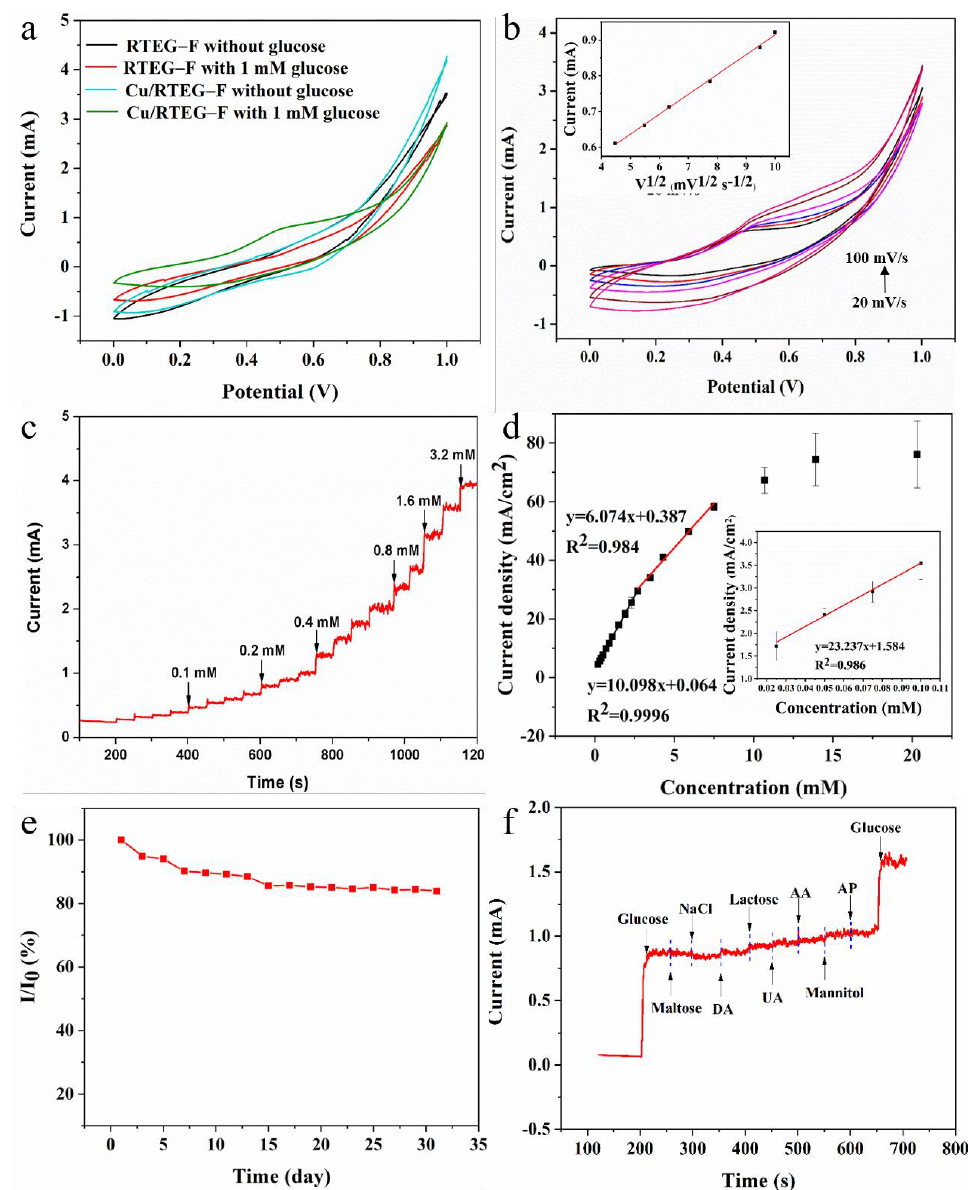
Figure 3. ( a ) CV curves of pristine RTEG-F and Cu/RTEG-F electrodes with or without the addition of 1.0 mM glucose at a scan rate of 50 mV s −1 . ( b ) CV curves of Cu/RTEG-F electrode at different scanning rates in NaOH solution containing 1.0 mM glucose. Inset: dependence of the glucose oxidation peak current on the scanning rate. ( c ) Amperometric current responses of Cu/RTEG-F electrode continuous adding of various concentration of glucose (e.g., adding four times of 1 µ L of 1.0 M glucose solution into NaOH solution will increase the concentration of glucose in the system to 0.025 mM every time). ( d ) The relationship between the glucose concentration (2.7 mM to 20.3 mM) and the corresponding current density. Inset: the relationship between the glucose concentration (0.025 mM to 2.7 mM) and the corresponding current density ( n = 3). ( e ) The relationship between the glucose concentration and the corresponding current density. ( f ) The current response of the Cu/RTEG-F electrode by the addition of 1.0 mM glucose, 0.1 mM maltose, NaCl, DA, lactose, UA, AA, mannitol, AP, and 1.0 mM glucose into 0.1 M NaOH solution.